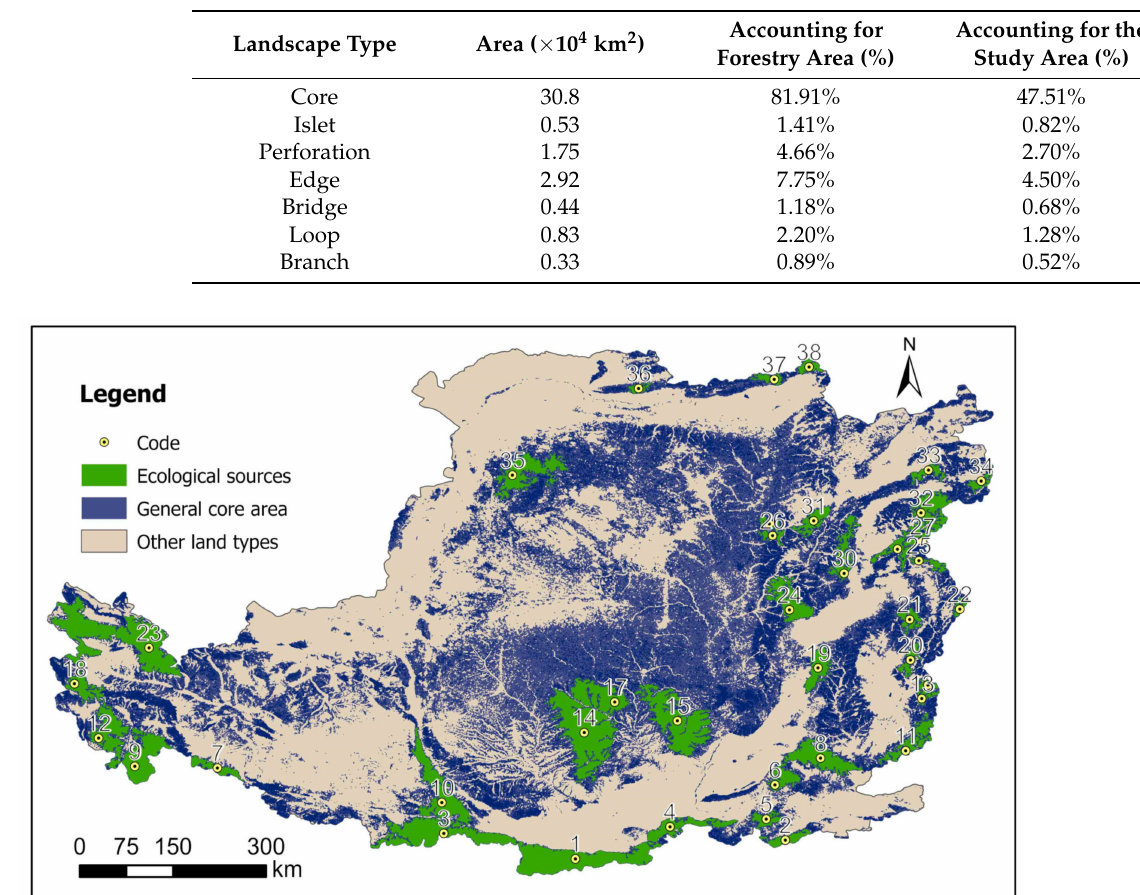
Figure 3. Spatial distribution of landscape pattern in LPC based on MSPA. ( a ) sample view of the edge; ( b ) sample view of the perforation; ( c ) sample view of the bridge. Table 4. Statistical areas of each landscape type.